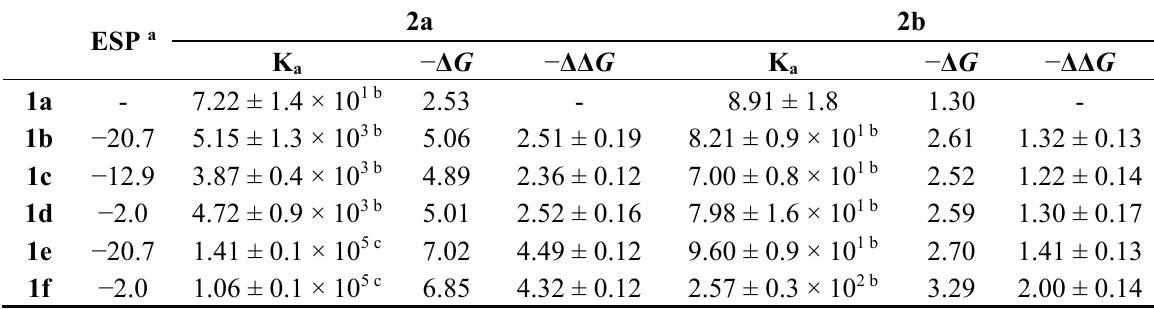
Table 1. Electrostatic Surface Potential (ESP) values (kcal·mol − 1 ), association constant values (K a , M − 1 ), free energies of complexation ( Δ G , kcal·mol − 1 ) measured in CH 3 CN at 298 K for the 1:1 complexes of guests 2a and 2b with calix[4]pyrroles 1a – f and free energy values calculated for CH- π interactions ( ΔΔ G , kcal·mol − 1 = Δ G ( 2a – b @ 1b – d ) − Δ G ( 2a – b @ 1a